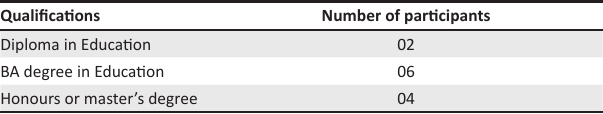
TABLE 5: Classification of respondents according to educational